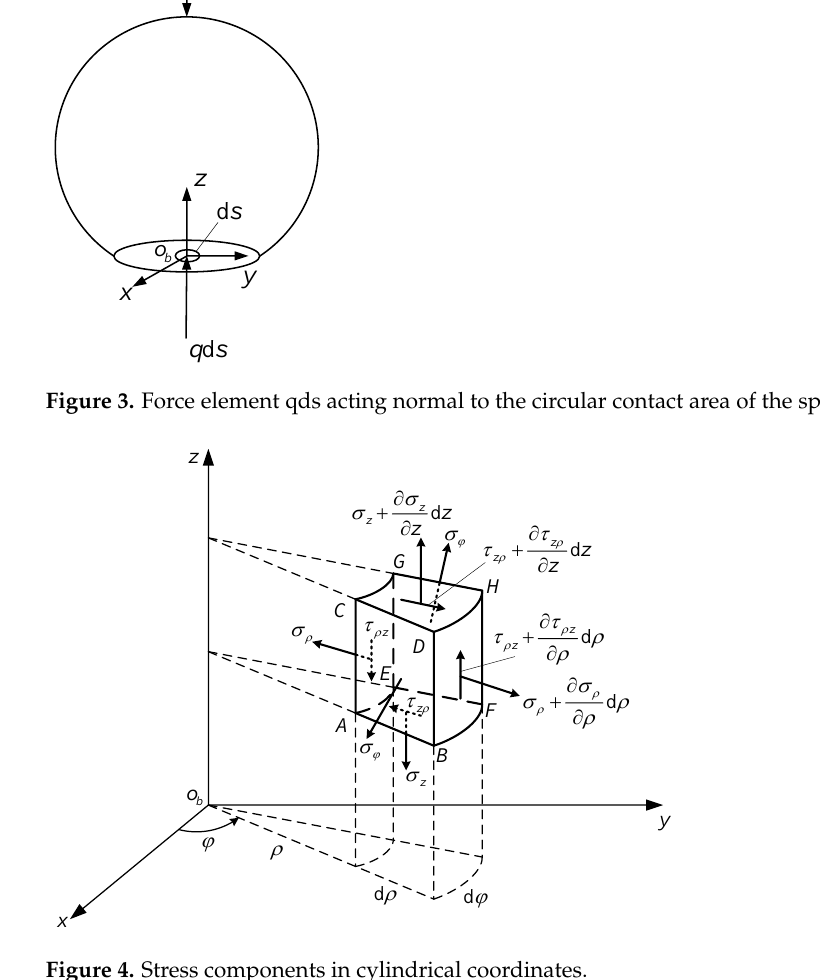
Figure 4. Stress components in cylindrical coordinates.